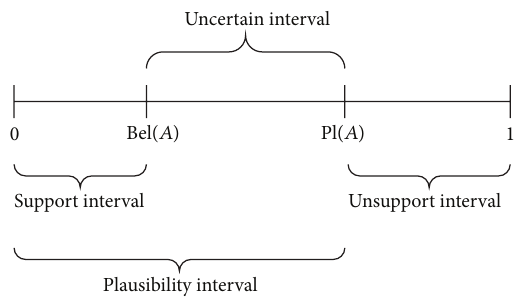
Figure 1: The relation between Bel (𝐴) and Pl (𝐴)